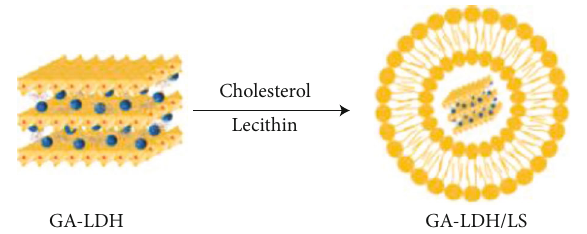
Figure 1: Schematic illustration for assembly of GA-LDH/LS